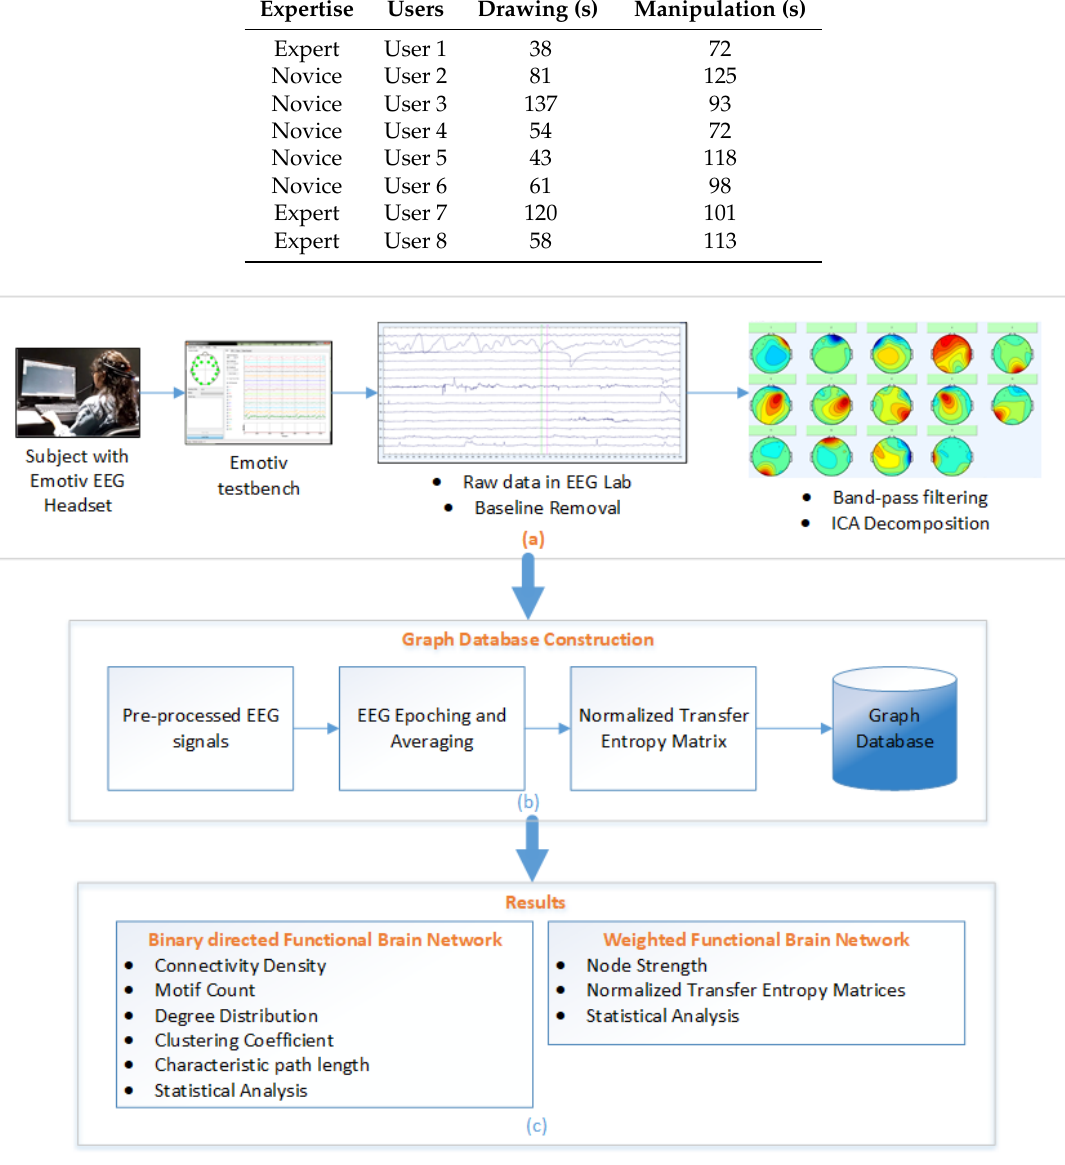
Figure 2. Normalized Transfer Entropy Framework ( a ) EEG data acquisition and pre-processing, ( b ) Transfer Entropy calculation and graph database construction, and ( c ) Result and analysis of binary and weighted